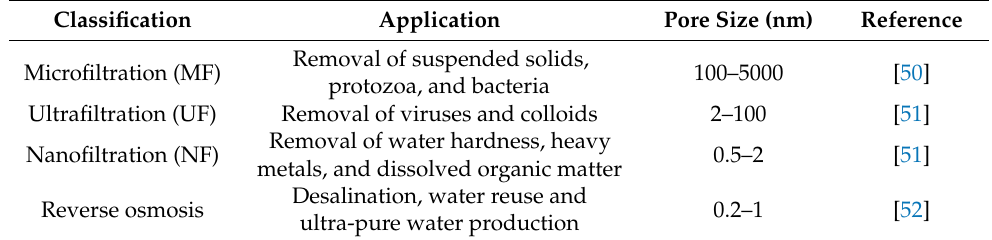
Table 1. Classification of membranes and their respective